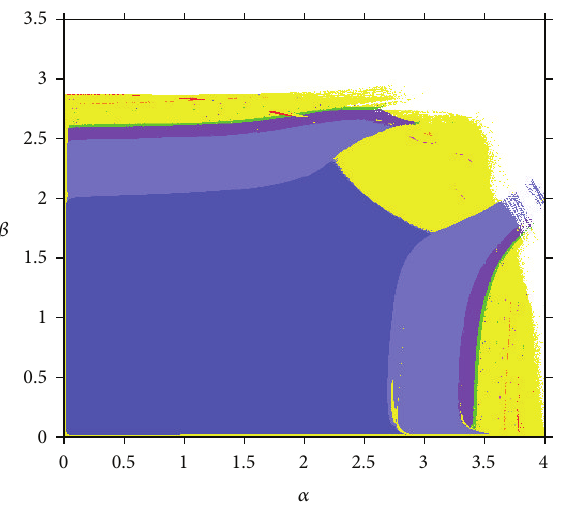
Figure 8: The parameter basin for 𝑑 = 0.7 .